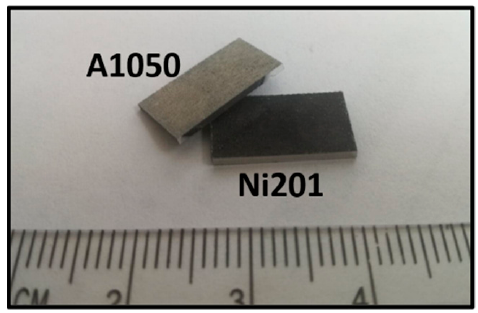
Figure 10. Disintegration of the Ni201/A1050 explosively welded clad manufactured by V d = 2000 m/s after 168 h of annealing at 500 °C.